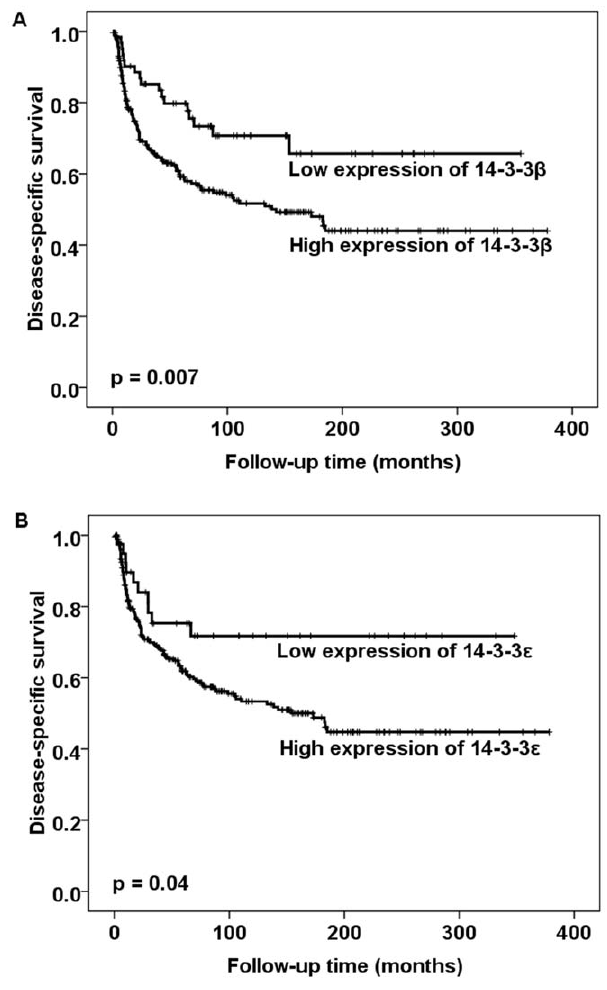
Figure 2. Survival curves using the Kaplan-Meier method. The Kaplan-Meier curve of disease-specific survival in relation to the cytoplasmic expression of 14-3-3 b and e . The p -value for 14-3-3 b differs slightly from that in Table 1 based on the use of the log-rank test in Figure 2 as opposed to the use of the Cox-regression analysis in Table 1.